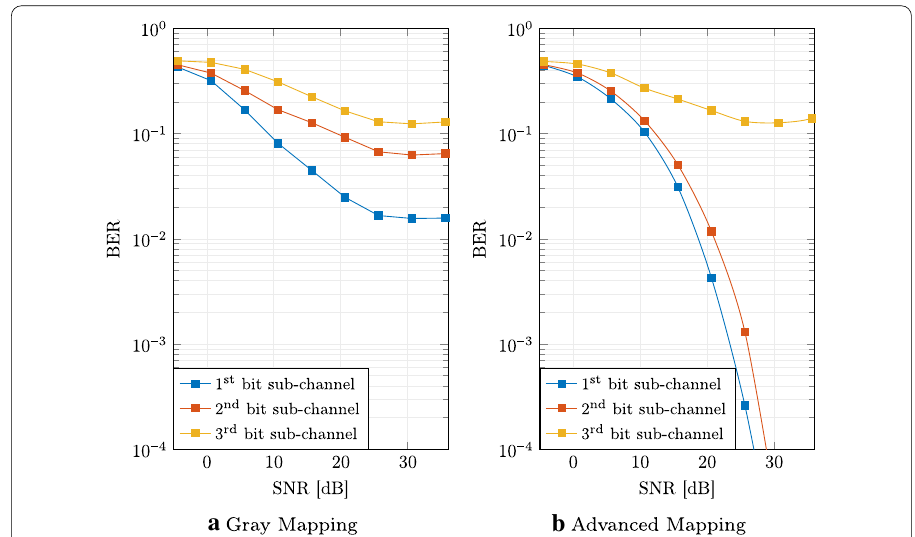
Fig. 6 BER results for each bit sub-channels according to the considered bit mapping, M = 3